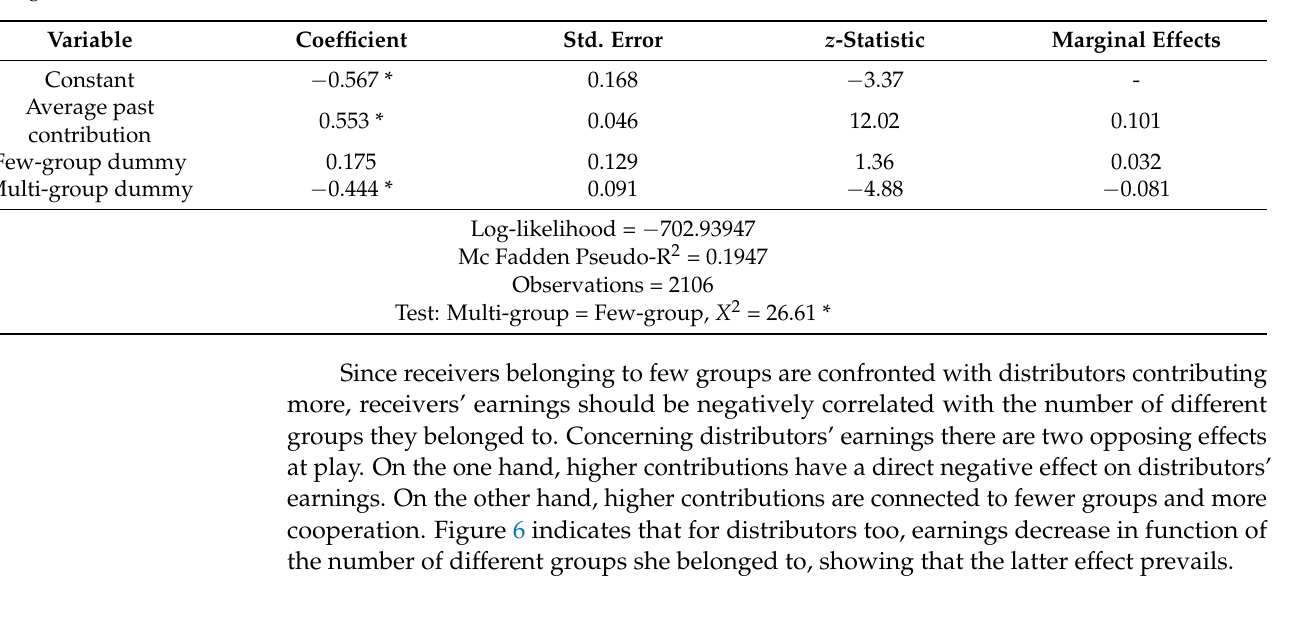
Table 3. Probit regression of the impact of average past contributions and number of groups a receiver belonged to on cooperative behavior. The dependent variable equals 1 if the receiver decides to cooperate and 0 otherwise. * indicates significance at the 1%